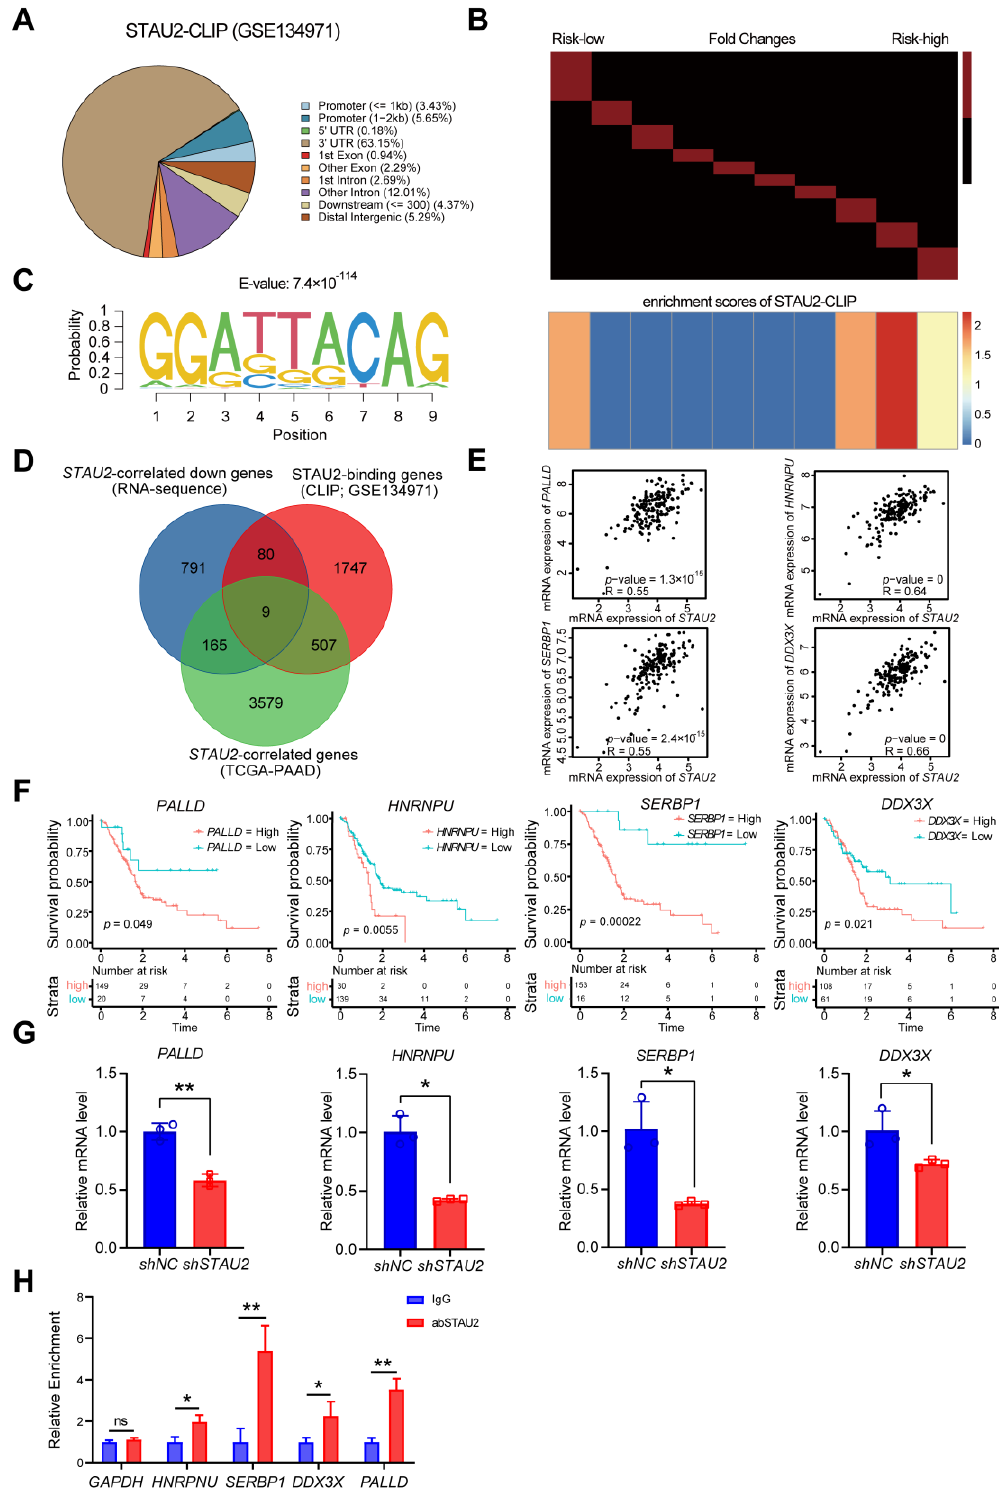
Figure 7. Identification of STAU2-target genes. ( A ) The genomic distribution of STAU2-CLIP peaks (GSE134971), presented by Venn diagram. ( B ) Heatmaps to show the ordered genes based on their fold-changes between low-risk and high-risk PAAD patients. These genes were then grouped into the same fraction (approximately 1000 genes per expression compartment). The red bar on a black background indicates the range of values for each container (the minimum value is − 2, and the maximum value is 2). The corresponding heatmap below shows the enrichment scores of STAU2; red or yellow represent the overrepresentation of the STAU2 binding motif, while blue represents the un- derrepresentation of the STAU2 binding motif. ( C ) Logo representation plots to show the putative